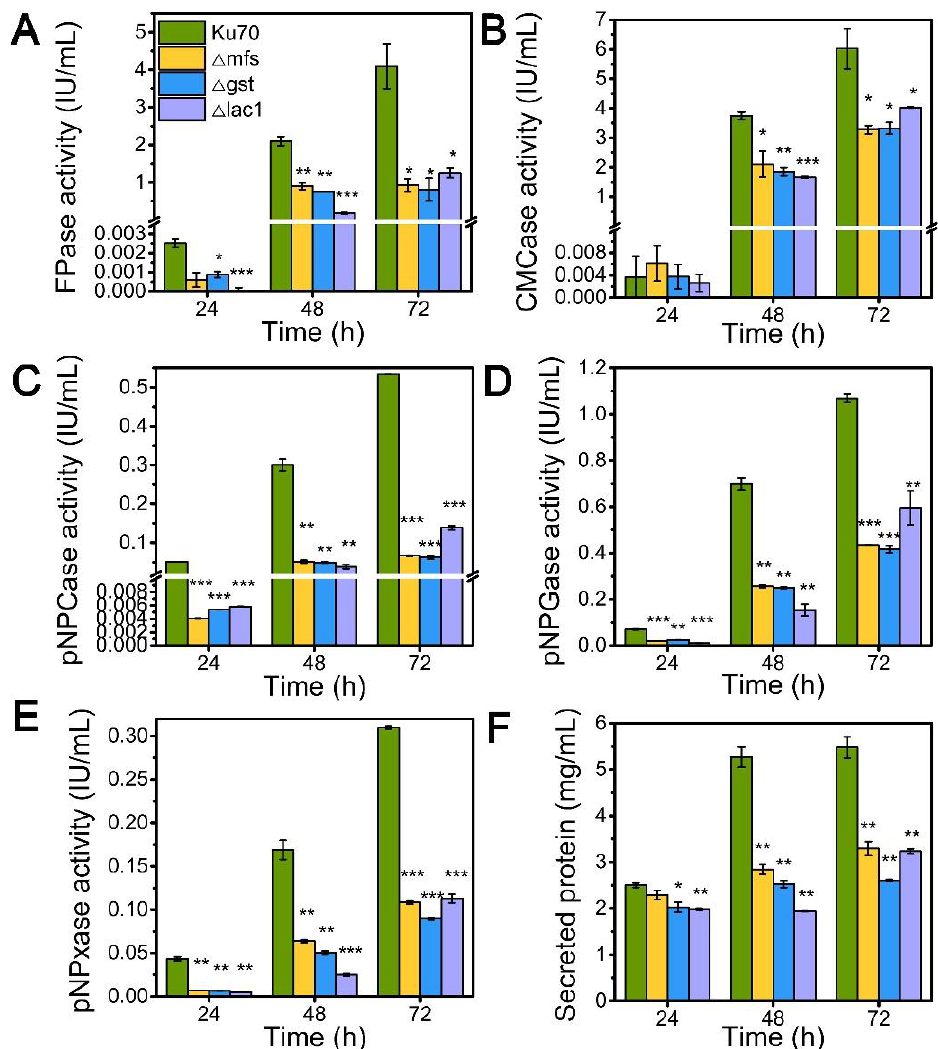
Figure 2. The cellulase and hemicellulase activities and protein secretion of T. reesei ∆ ku70, ∆ mfs, ∆ gst, and ∆ lac1 cultured in TMM+2% lactose at 24 h, 48 h, and 72 h, respectively. ( A ) FPase: the filter paper activity; ( B ) CMCase: the CMC activity; ( C ) pNPCase: the CBH activity; ( D ) pNPGase: the BGL activity; ( E ) pNPxase: the xylanse activity; ( F ) protein secretion. Values are the means of three biological replicates, and error bars are the standard deviations of these three replicates. Asterisks indicate significant differences (* p < 0.05, ** p < 0.01, and *** p < 0.001) as assessed by the Student’s t